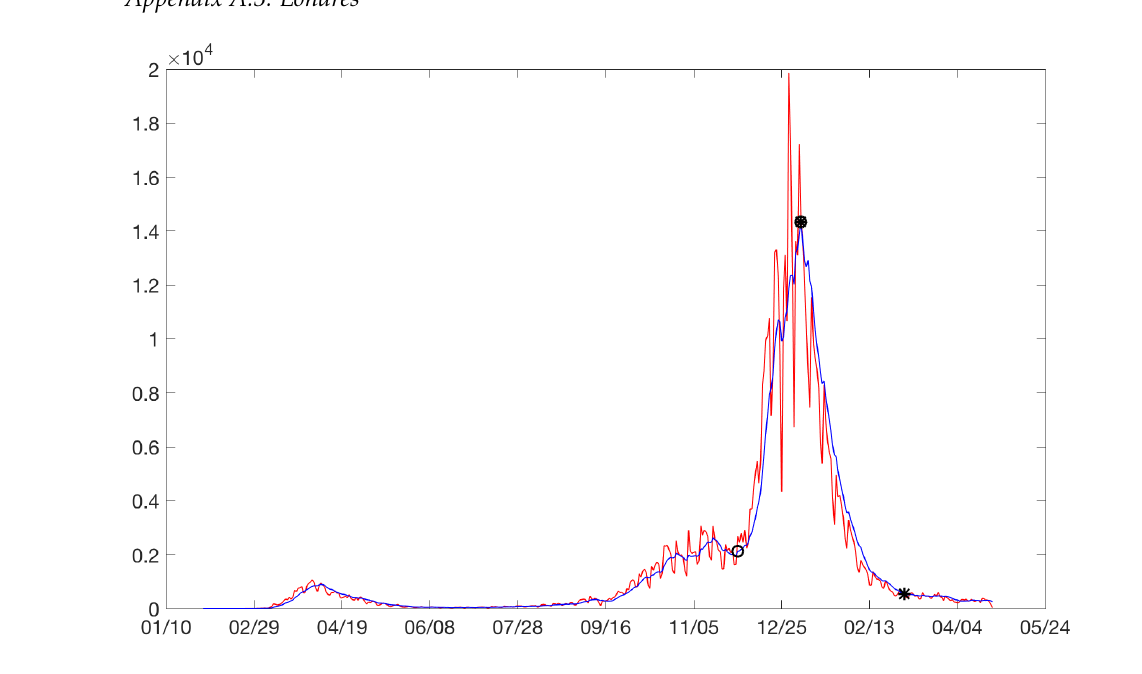
Figure A7. London: on the horizontal axis is the date in days and on the vertical axis are the daily cases.